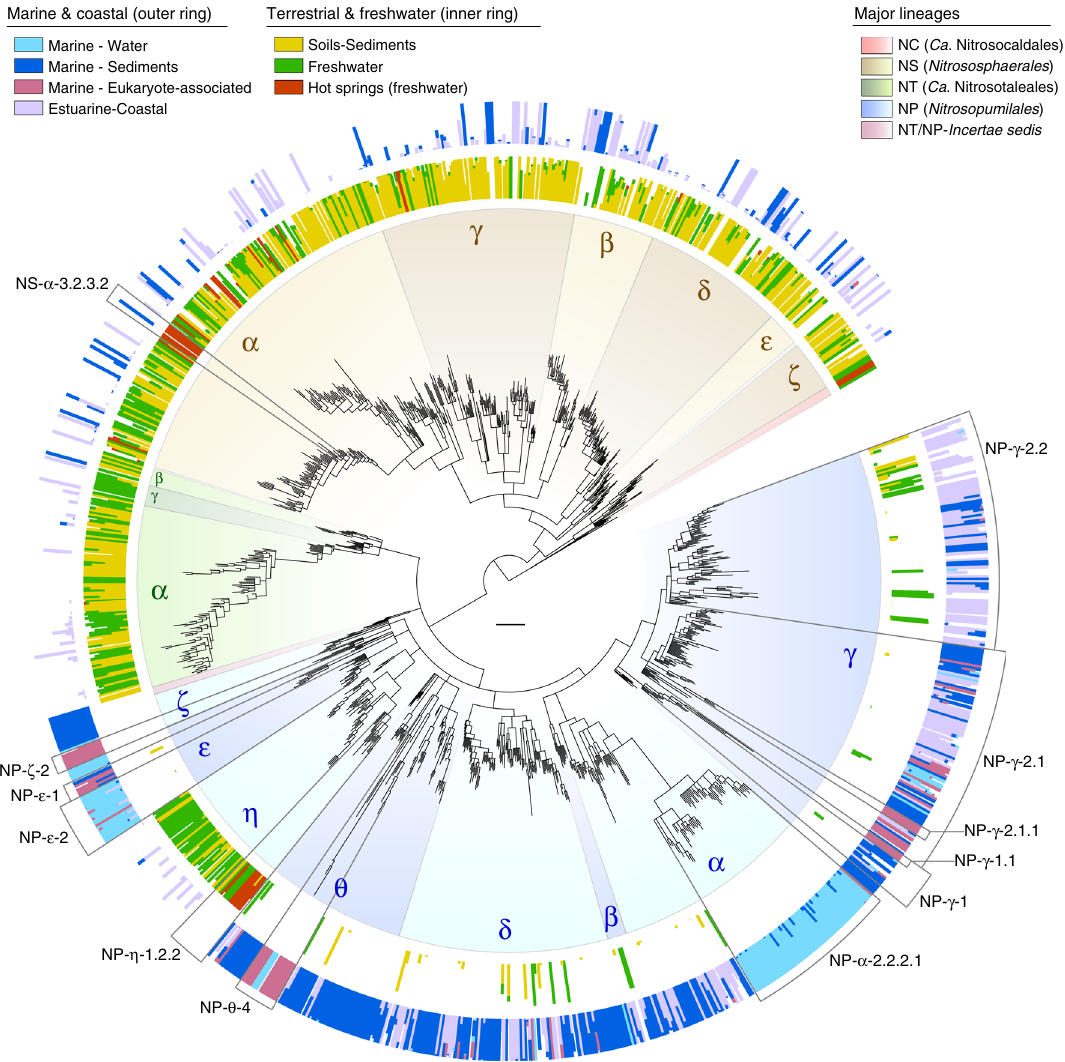
Fig. 6 Distribution of archaeal amoA genes in fi ve broad habitats. The environmental occurrence of 31,932 amoA genes unambiguously assigned to one of fi ve broad habitats is represented as fraction of sequences in each OTU (96% sequence identity). Fractions were calculated in relation to total number of sequences in the OTU assigned to a habitat within the same category level, excluding those only assigned to the broader category above (e.g., fraction of sequences from each marine habitat were calculated relative to all marine sequences, excluding those that could only be categorised as marine). Subclades speci fi ed in the main text are indicated by grey lines. The scale bar represents 0.1 substitutions per nucleotide position. The absolute and relative phylogenetic/taxonomic distribution of sequences in these and more speci fi c habitats are available in interactive Krona 47 charts (Supplementary Data 4- 9). See legend of Fig. 1 for tree